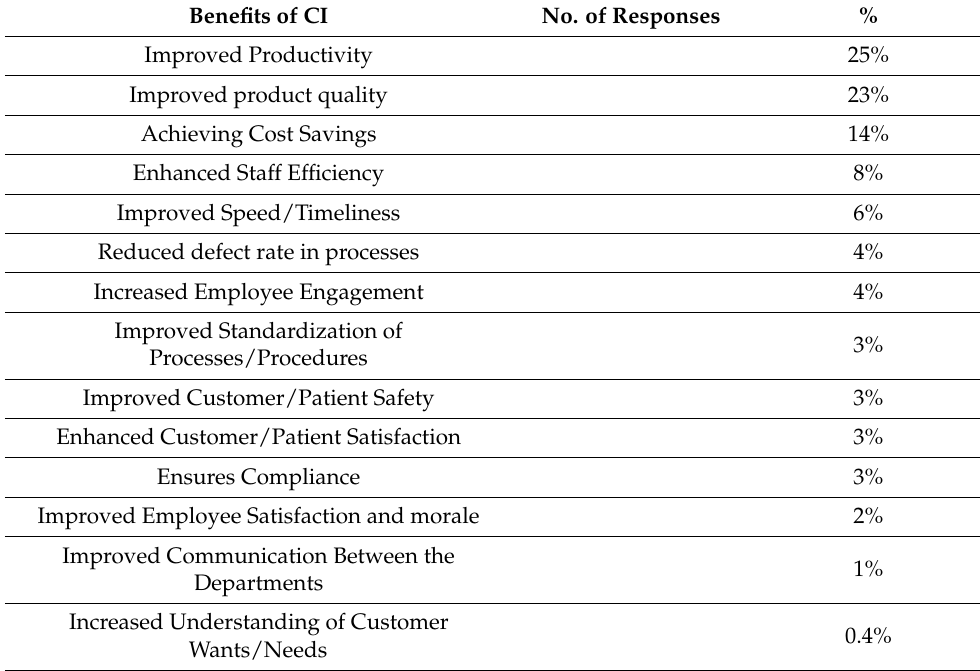
Table 4. The Benefits of CI in the Irish Pharma